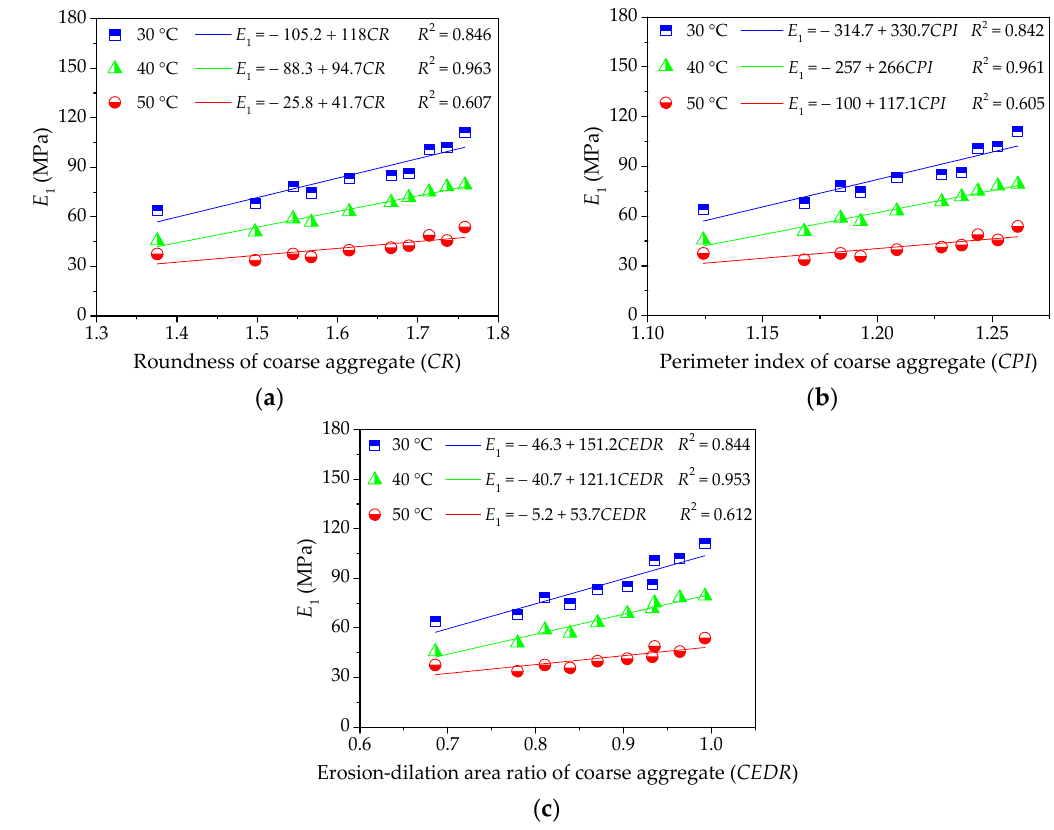
Figure 11. Influences of coarse aggregate morphological characteristics of on E 1 of asphalt mixture: ( a ) Shape ( CR ); ( b ) Angularity ( CPI ); and, ( c ) Texture ( CEDR ).